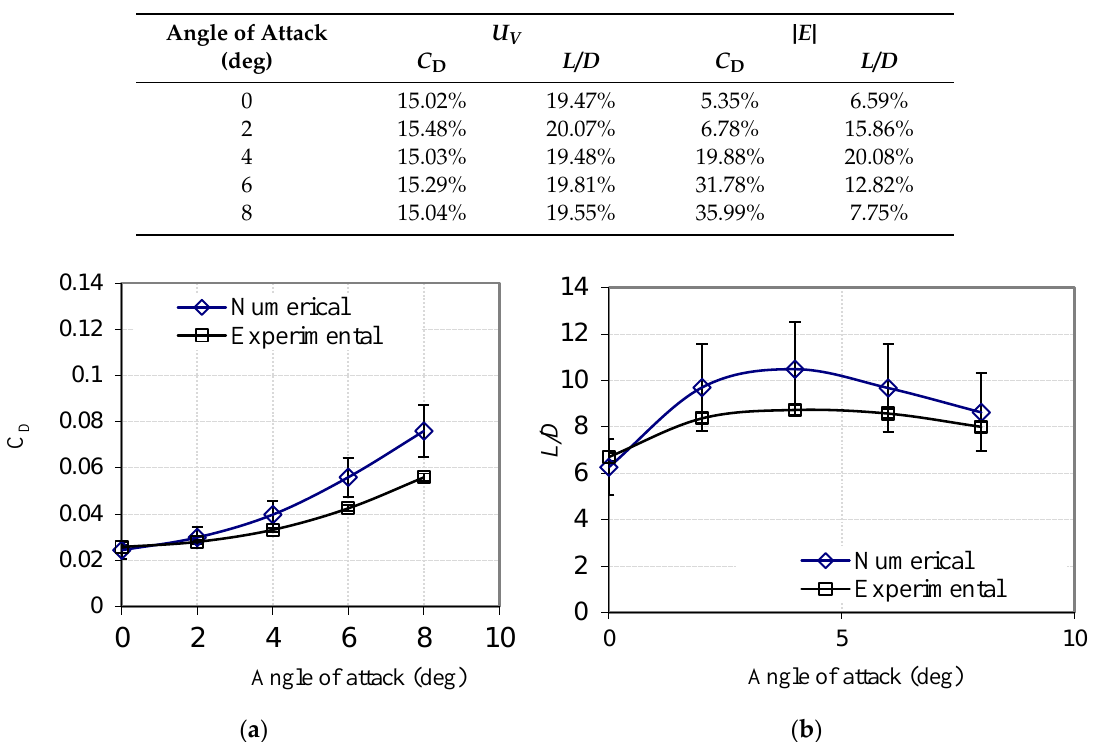
Figure 6. Comparison between numerical and experimental simulation for the compound wing for drag coefficient ( a ) and lift-to-drag ratio, ( b ) with simulation and experimental data uncertainty bars for the velocity of 25.5 m/s and a ground clearance of 0.15. Table 2. Validation Uncertainty and Comparison Error for Drag coefficient and Lift-to-drag ratio for the compound wing at a velocity of 25.5 m/s and ground clearance of 0.15.